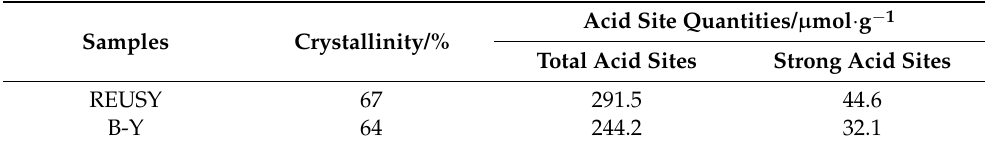
Table 2. Physicochemical properties for REUSY and B-Y zeolites.